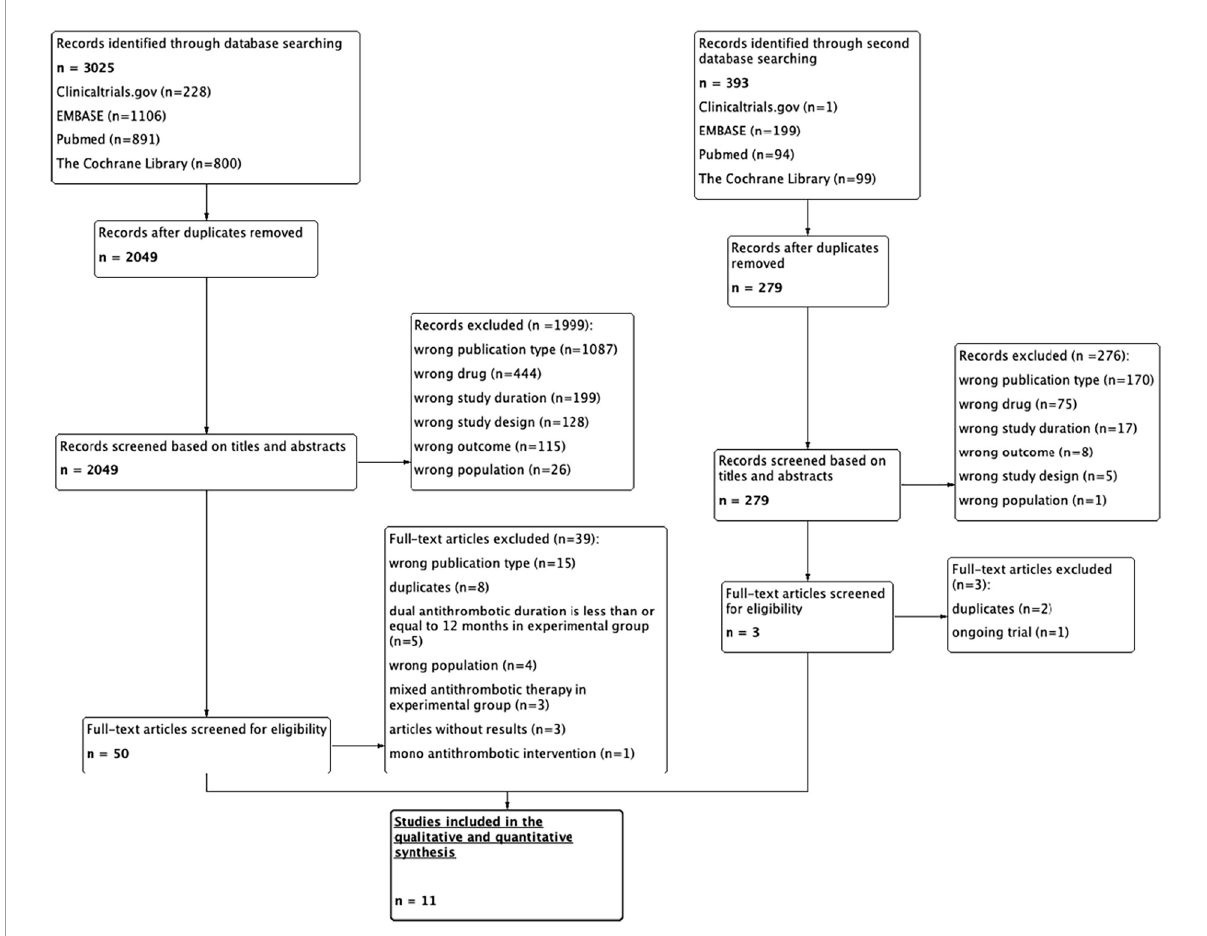
FIGURE1 A flow diagram of the selection of studies for the network